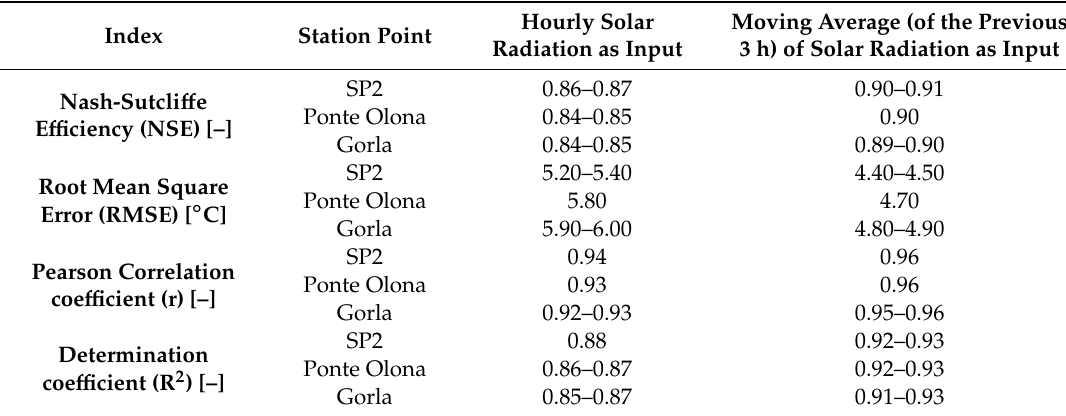
Table 7. Statistical indexes during clear sky days between observed and forecasted LST values by the MEC algorithm using the hourly solar radiation and the 3 h-moving average as input.